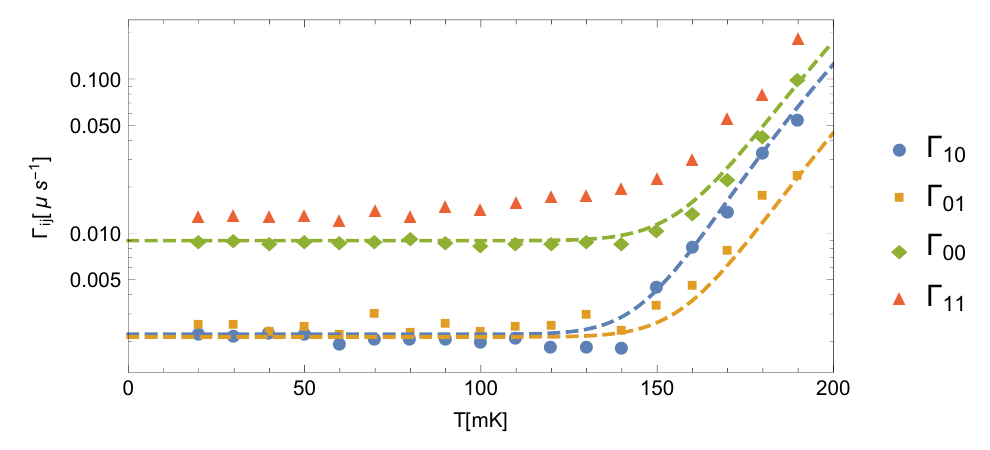
Figure 6: (data points from Ref. [ 19 ] ) Symbols: experimental data for the transition rates vs temperature. Dashed lines: theoretical rates calculated using Eq. (100) and the parameters given in the